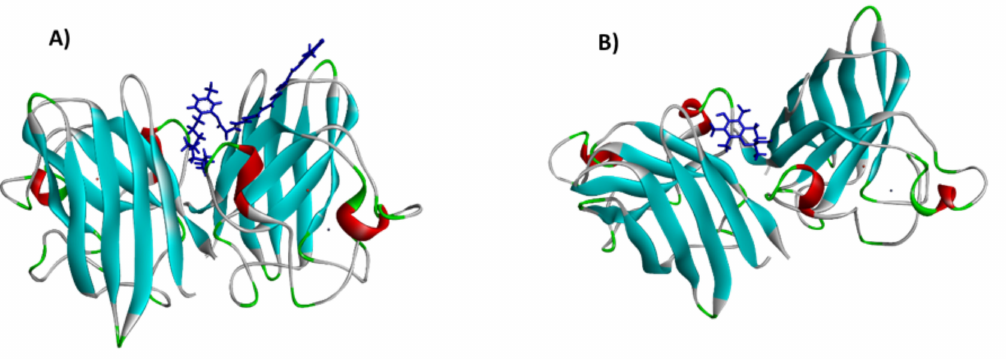
Figure 7. Three-dimensional structure of ( A ) Flexirubin and ( B ) Trolox to cavity site of Cu/Zn superoxide dismutase enzyme generated by BIOVIA discovery studio visualizer (version